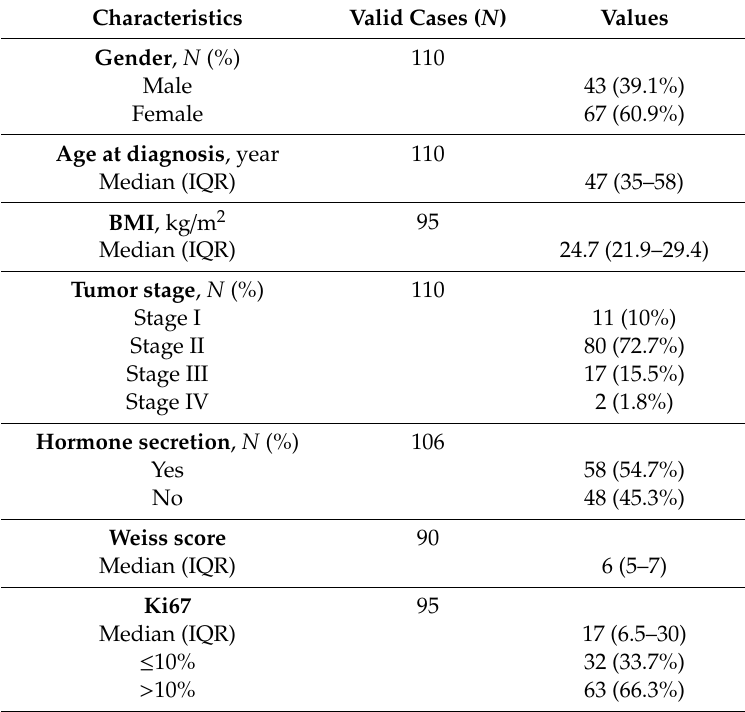
Table 1. Baseline features of patients. IQR = interquartile range. BMI = Body Mass Index.